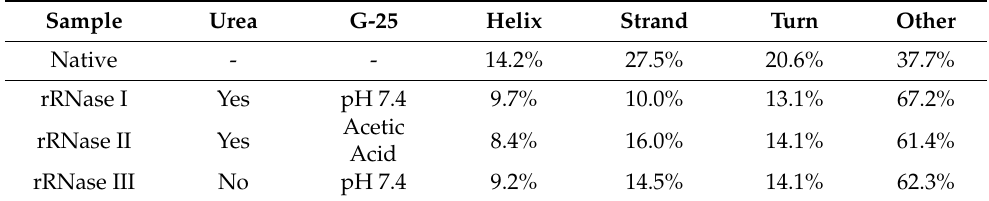
Figure 3. Spectroscopic analysis of the three rRNase I, rRNase II and rRNase III. ( A ) CD spectra of native RNase (black line), rRNase I (red line), rRNase II (orange line), and rRNase III (brown line). ( B ) Intrinsic fluorescence emission spectra of native RNase (black line), rRNase I (red line), rRNase II (orange line), and rRNase III (brown line). The CD spectra and the fluorescence emission spectra were recorded with a protein concentration of 1.25 µM in 10 mM sodium phosphate buffer pH 7.4 at 25 °C. Table 4. Secondary structure analysis of the CD spectra of rRNases.